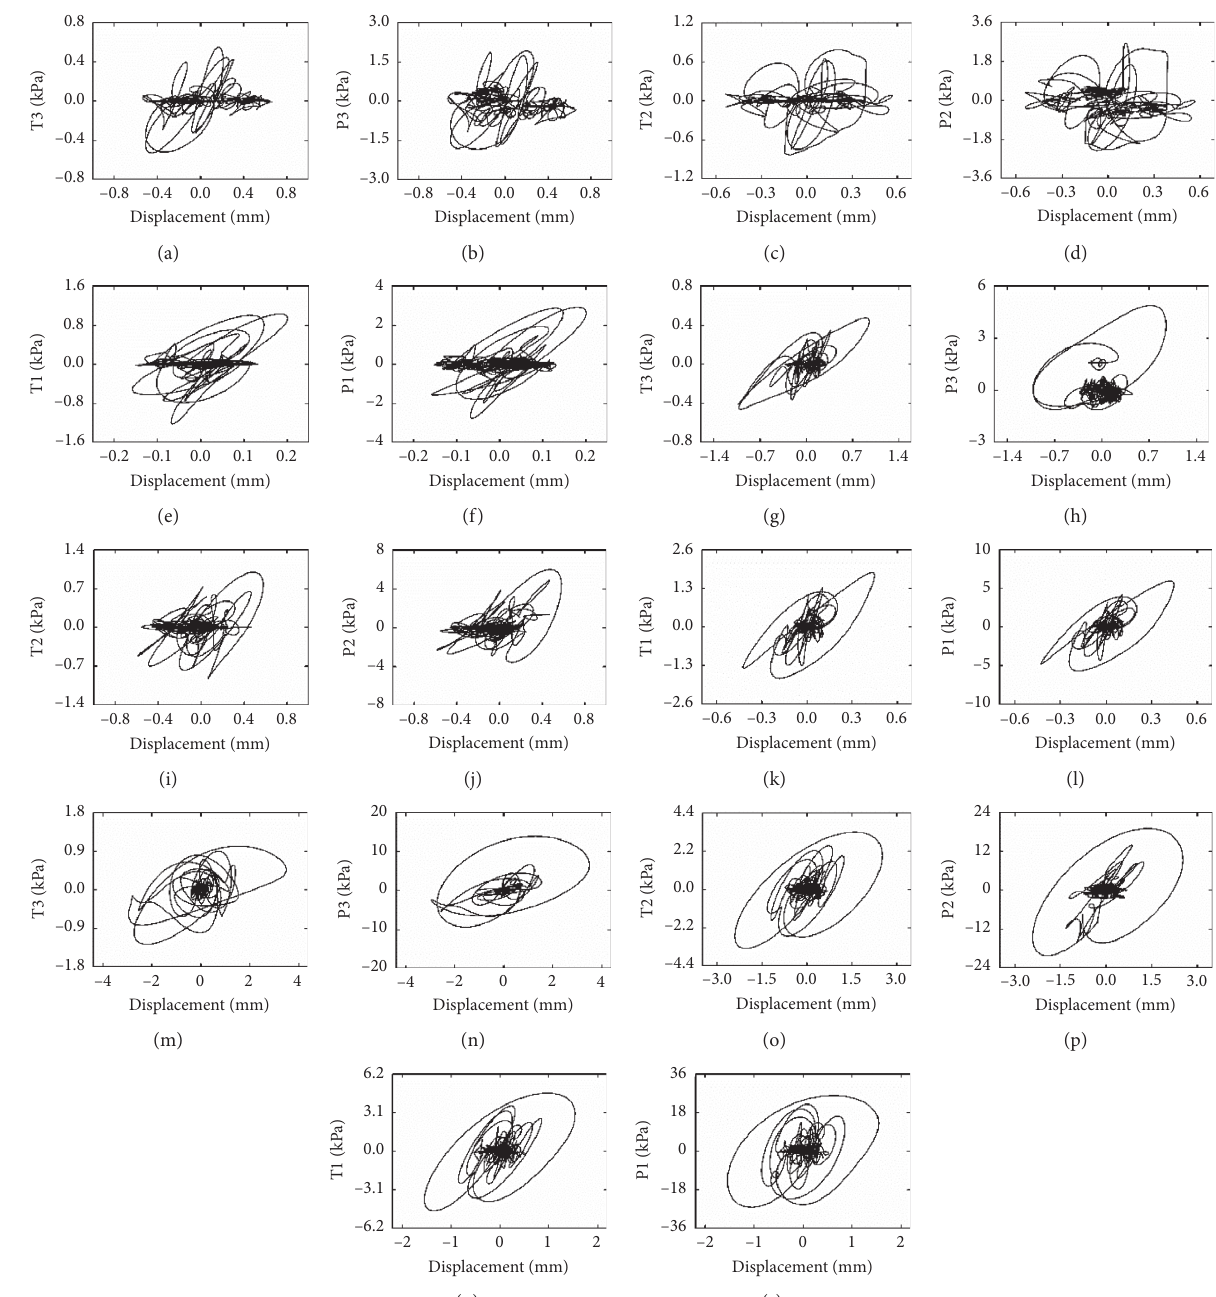
Figure 7: Hysteresis curves of horizontal normal stress and shear stress versus displacement: (a) (b) T3 and P3 under 0.1g excitation. (c, d) T2 and P2 under 0.1g excitation. (e, f) T1 and P1 under 0.1 g excitation. (g, h) T3 and P3 under 0.2g excitation. (i, j) T2 and P2 under 0.2g excitation. (k, l) T1 and P1 under 0.2g excitation. (m, n) T3 and P3 under 0.4g excitation. (o, p) T2 and P2 under 0.4 g excitation. (q, r) T1 and P1 under 0.4 g